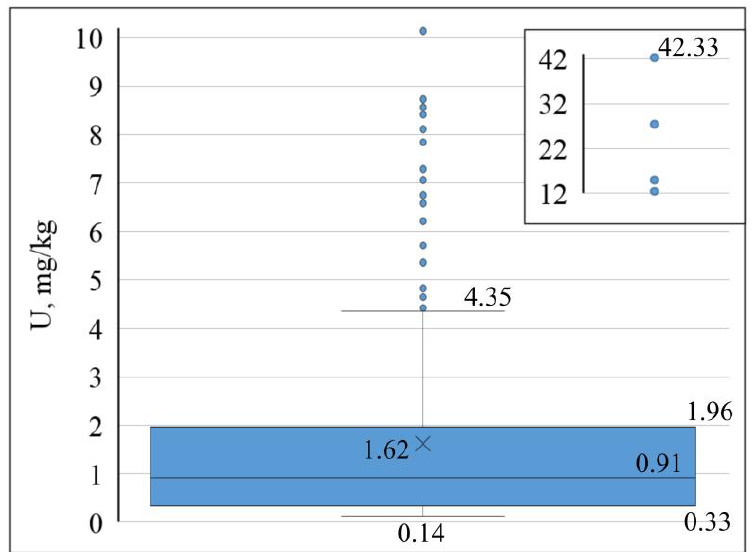
Figure 2. Variation of U concentration in the sediments of lakes in the Republic of Karelia with the main statistical parameters; from bottom to top: the minimum value of the sample, the lower quartile (25th percentile), the median, the arithmetic mean (indicated by a cross), the upper quartile (75th percentile), the maximum value of the sample, the extremely high values that stand out from the total sample (indicated by circles).